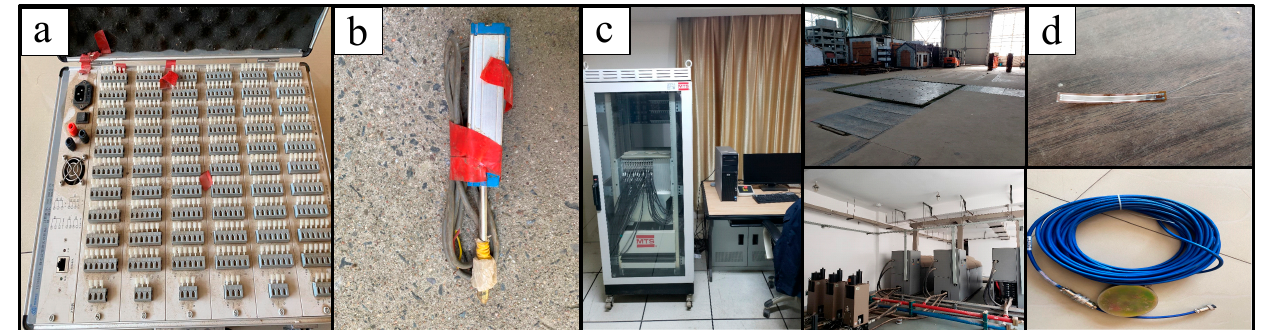
Figure 1. ( a ) Static strain indicator, ( b ) displacement meter, ( c ) shaking table system, and ( d ) strain gauge and pressure box.